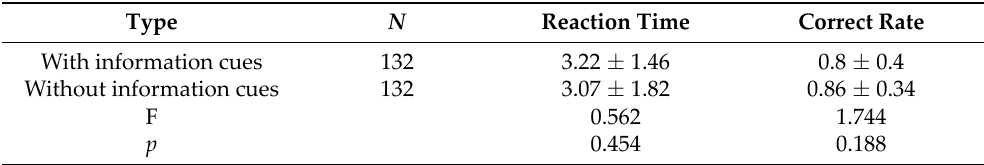
Table 8. Results of descriptive statistics of response time and correctness in conditions with and without information cues.